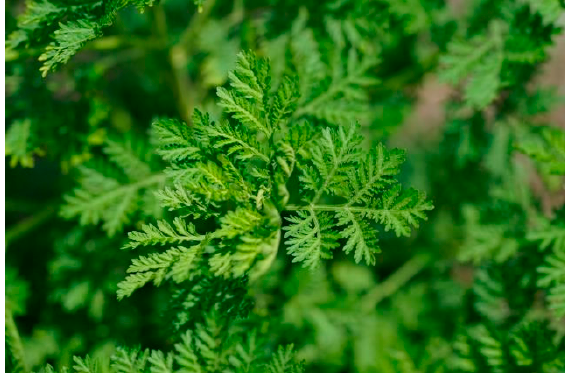
Figure 1. Artemisia annua [9].